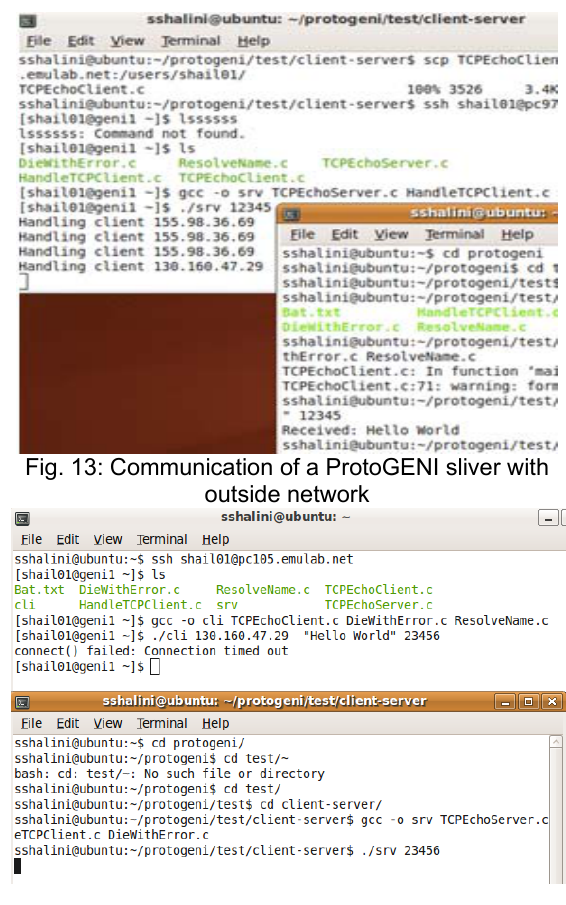
Fig. 15: Kentucky Emulab ProtoGENI node as server